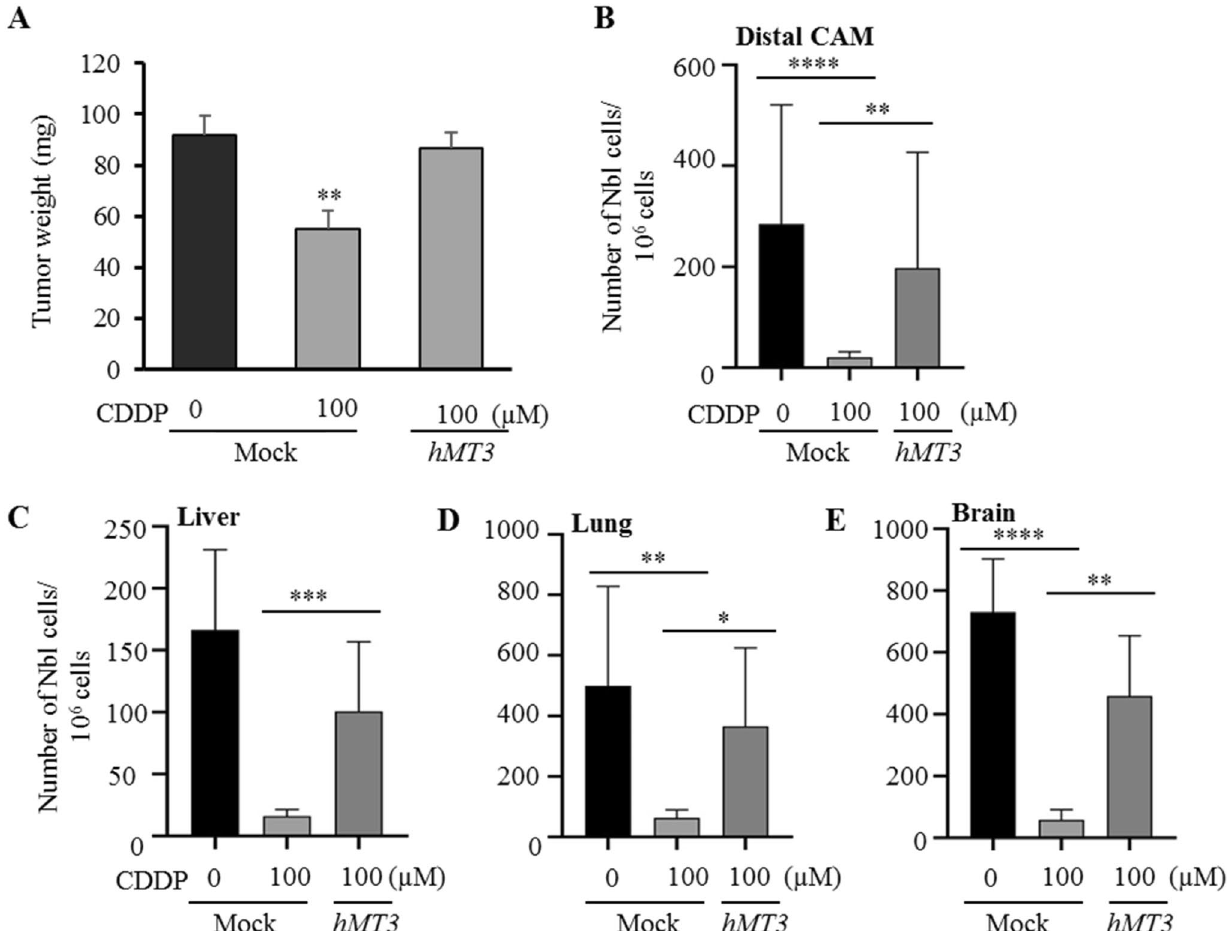
Figure 3. Evaluation of efficiency of CDDP to inhibit tumour growth and metastatic spread in UKF-NB- 4 mock cells and their hMT3 counterparts. ( A ) Weights of tumours excised from the CAM upon experiment termination (17 th day). Numbers of Nbl cells identified in ( B ) distal CAM (extravasation), ( C ) liver, ( D ) lung and ( E ) brain (intravasation). Quantitation of Nbl cells was based on qPCR using Alu primers. In addition, qPCR of chicken GAPDH was performed as an internal control to confirm the presence of equivalent quantities of host genomic DNA. Data shows average ± SEM from three (n = 3) independent experiments. *p < 0.05; **p < 0.005, ***p < 0.001, ****p <